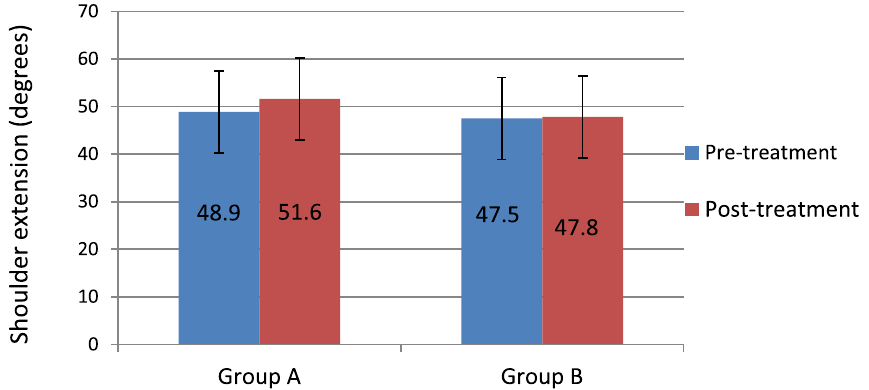
Fig. 11 Mean values of shoulder abduction pre- and post-treatment within each